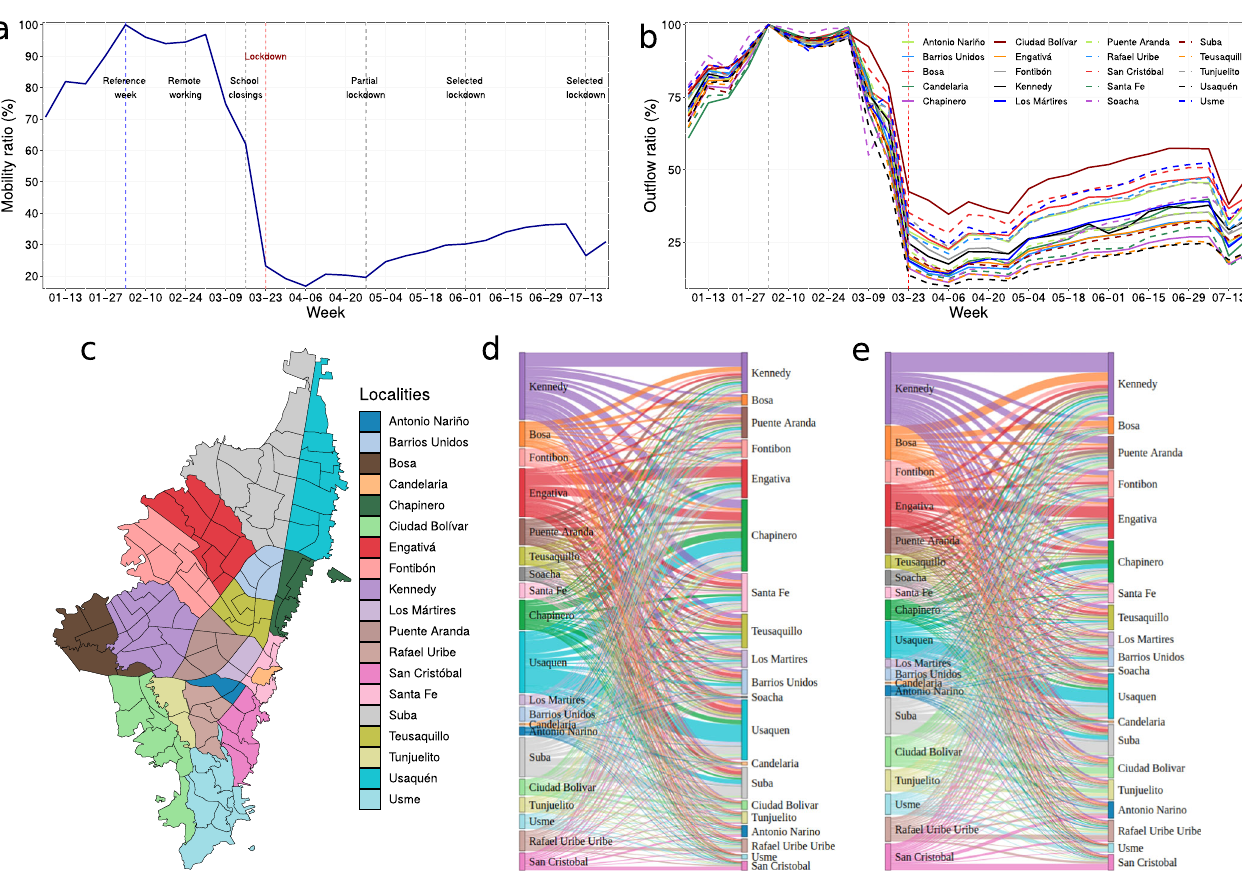
Fig. 1 Evolution of mobility fl ows in the city of Bogotá. a Total mobility ratio in percentage. Vertical lines indicate the implementation of different policies. b Out fl ow ratios (%) for localities. c Map of urban localities and zonal planning units (UPZ). d and e Mobility fl ows between localities in the reference week (February 3) and in the lockdown (March 23), respectively. Key dates: February 3 the reference week; February 24 requests of remote working for private companies; March 16 schools closing; March 23 implementation of strict lockdown; April 27 partial lockdown; June 1 – 14, and since July 13 selected strict lockdowns in some